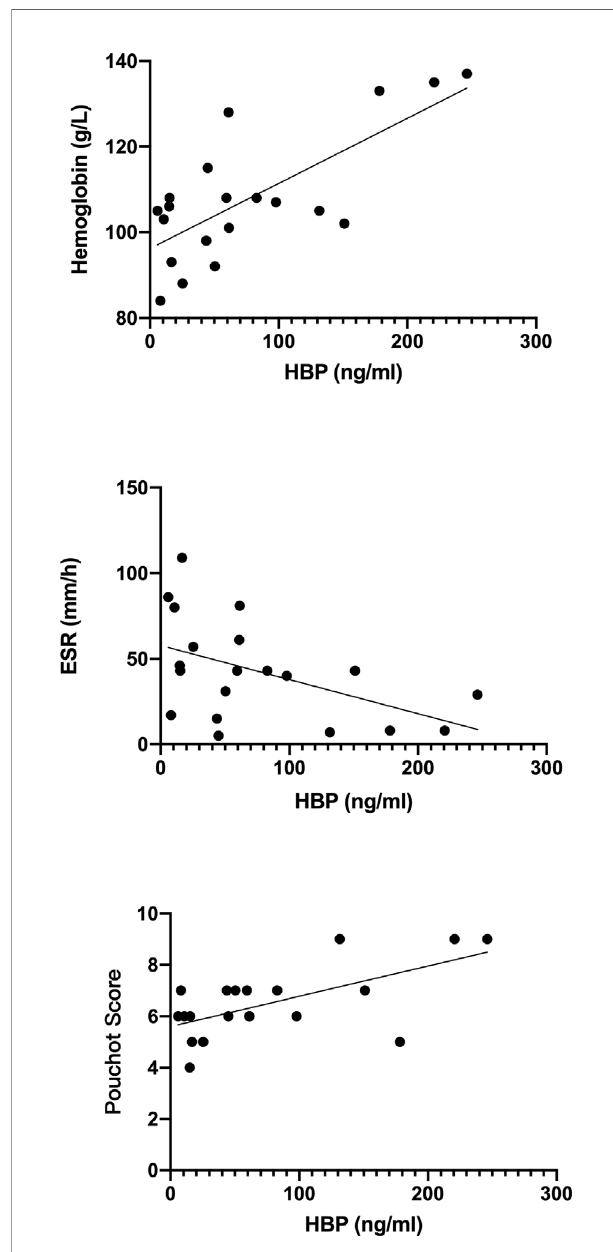
FIGURE 2 | Correlations between heparin-binding protein (HBP) and other laboratory indicators in blood taken from patients with active adult-onset Still ’ s